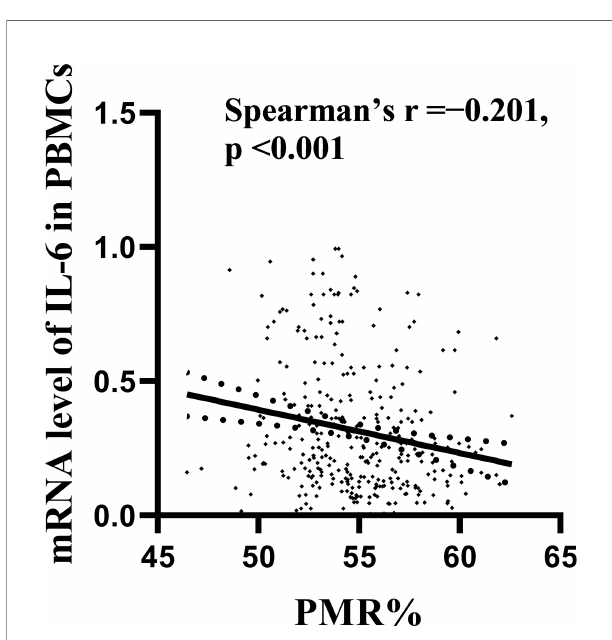
FIGURE 4 | Relationships between IL-6 promoter methylation levels and mRNA levels in PBMCs. A signi fi cant correlation was observed between the PMR value of the IL-6 promoter and the mRNA level in PBMCs (Spearman ’ s r=-0.201, P < 0.001).